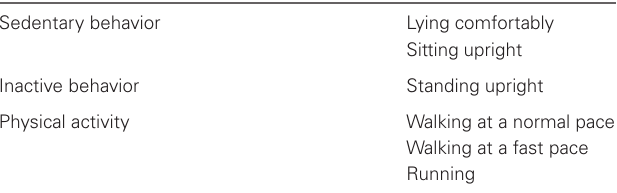
Table 1 | The six activities conducted in the reference measurements, classified as sedentary behavior, inactive behavior, or physical activity (moderate and